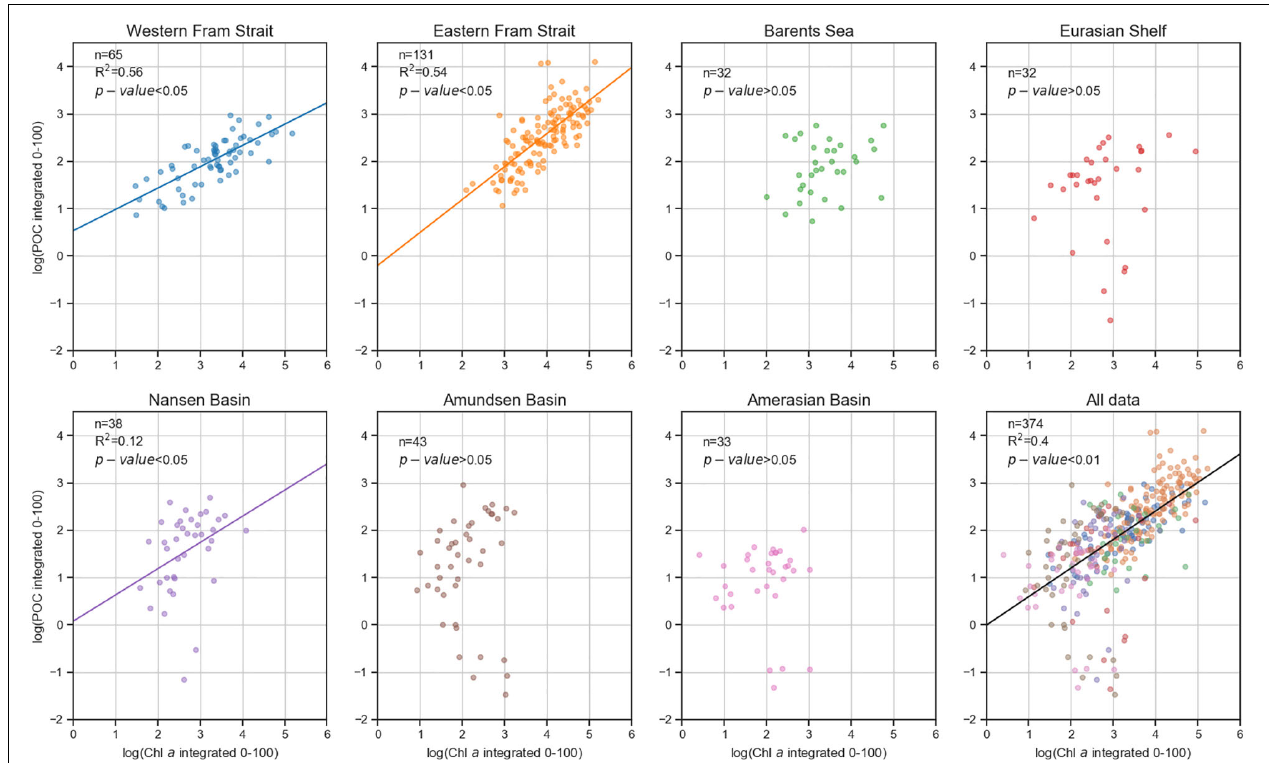
FIGURE 5 | Logarithmic relationship between Chl a and POC values for each sub-region sampled from 1991 to 2015. Statistics are shown in Table 2 .